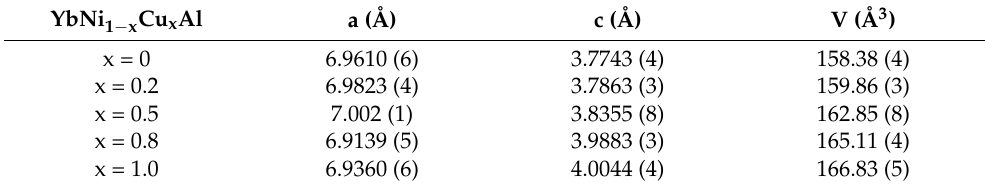
Table 1. Lattice parameters (a, c) and volume (V) as calculated by Rietveld refinements of the X-ray diffraction data of the YbNi 1 − x Cu x Al series of alloys.